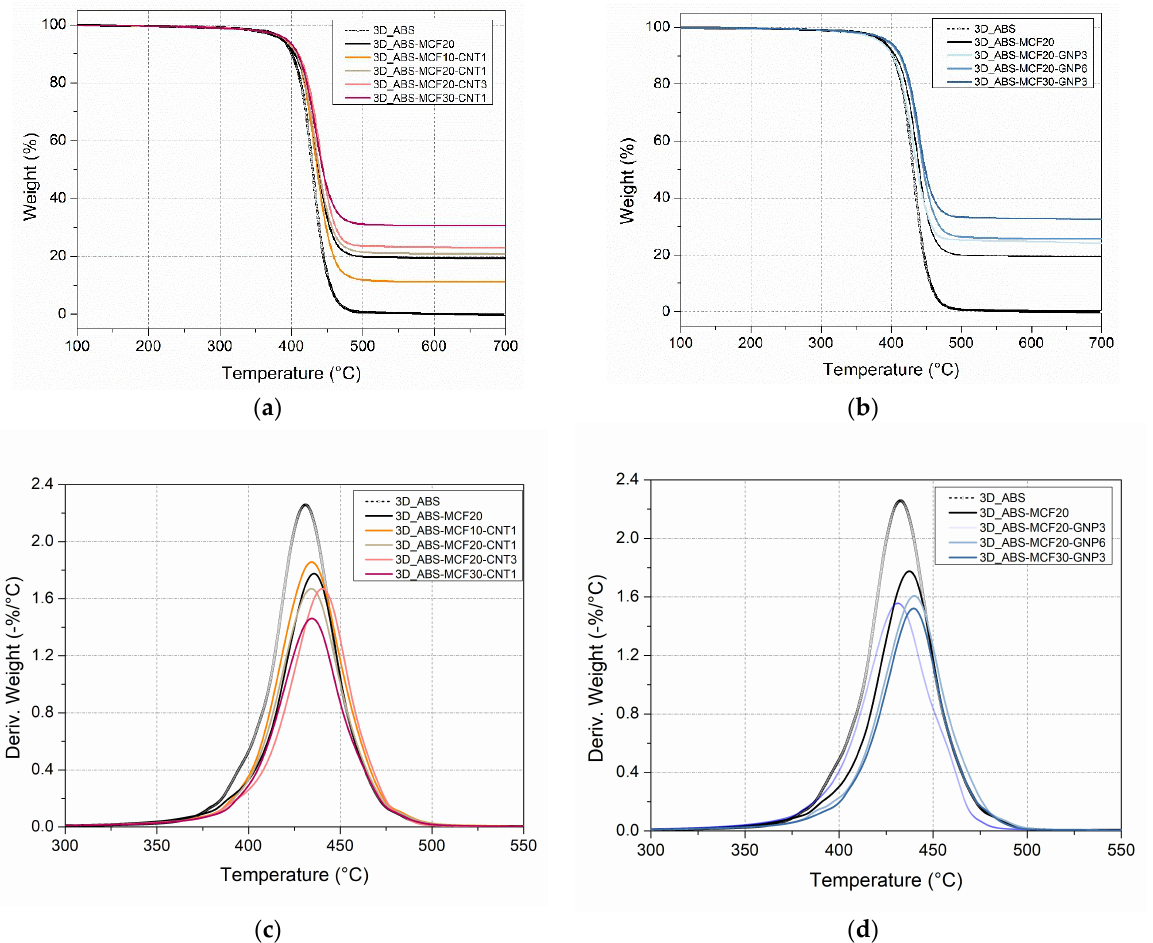
Figure 12. TGA and DTGA curves of multiscale composite 3D-printed samples under nitrogen atmosphere: ( a , b ) residual mass as a function of temperature; ( c , d ) derivative of the mass loss. Table 7. TGA data of pure ABS and multiscale composite printed samples in a nitrogen atmosphere.